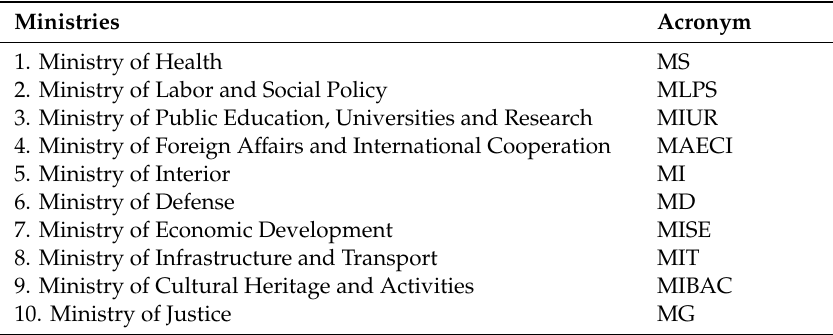
Table 2. Italian Ministries part of the analysis and